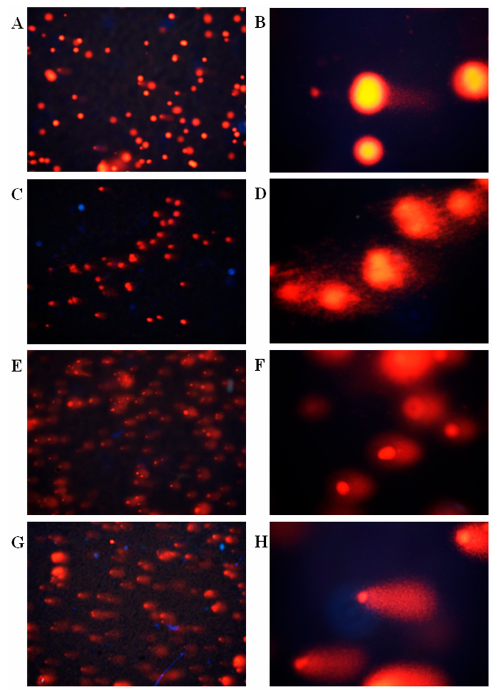
Figure 5. Effects of different concentrations of ellagic acid microspheres on HepG2 cells: ( A , B ) control group; ( C , D ) 0.1 g/L ellagic acid microspheres; ( E , F ) 0.3 g/L ellagic acid microspheres; ( G , H ) 0.5 g/L ellagic acid microspheres ( A , C , E , G , 100 × ; B , D , F , H 400 × ). Molecules 2017 , 22 , 2175